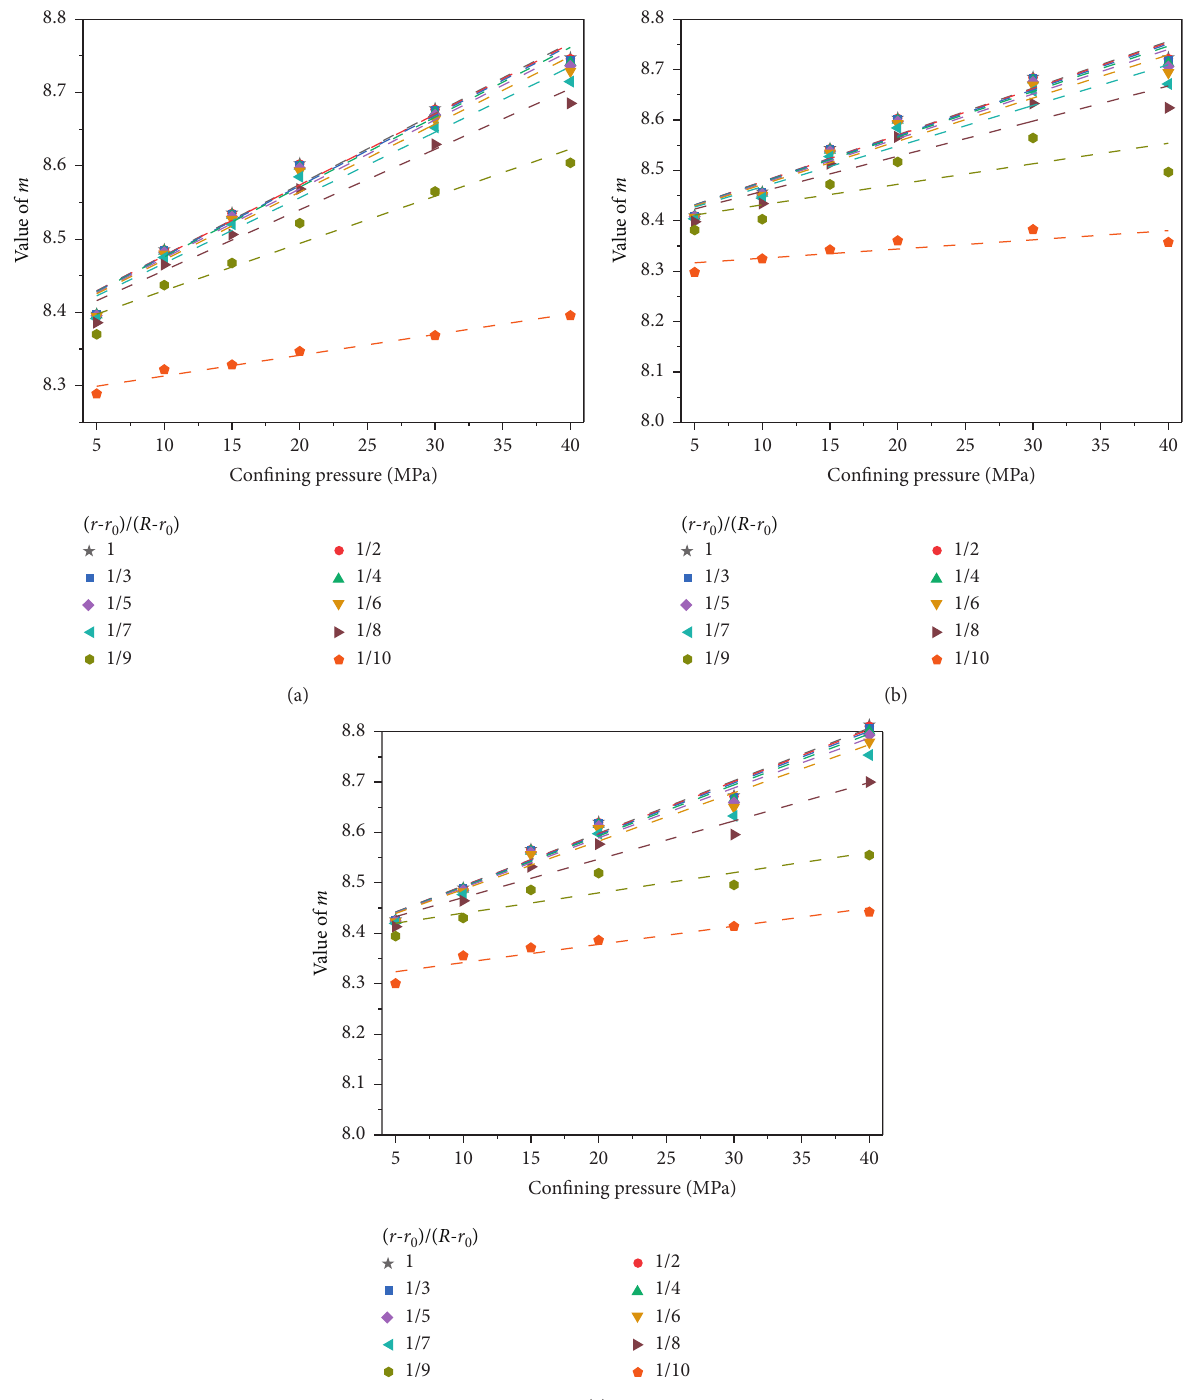
Figure 12: Scatter diagram of m changing with confining pressure. (a) The specimens with an aperture of 10mm. (b) The specimens with an aperture of 15mm. (c) The specimens with an aperture of